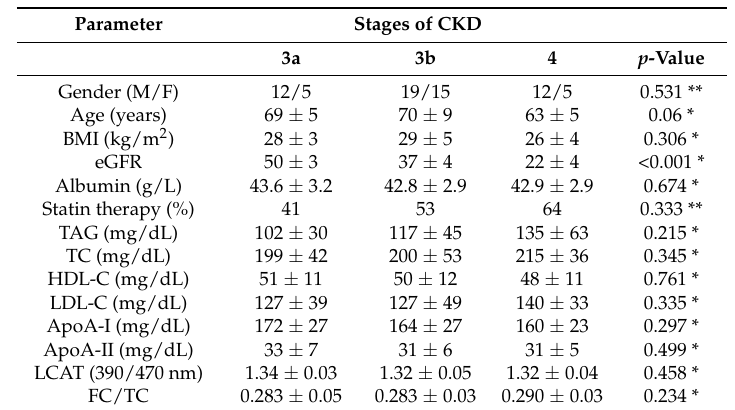
Table 1. Characteristics of patients at various stages of chronic kidney disease (CKD).